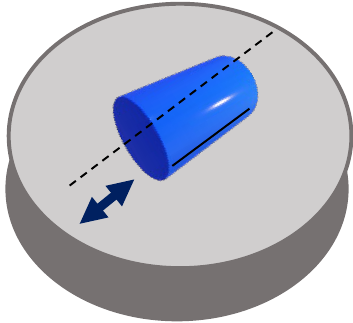
Figure 3. Tribological contact: cylinder on disk.